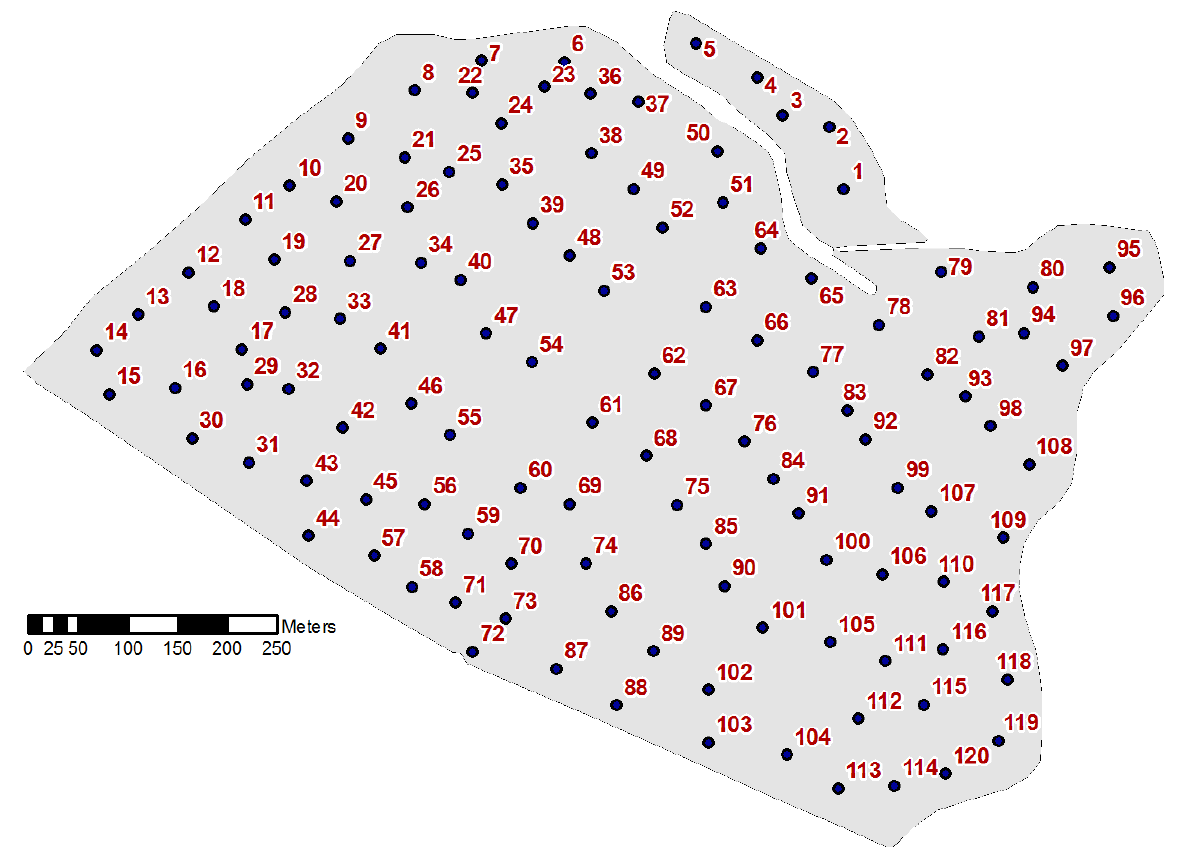
Figure 3: Soil sampling scheme in a 56-ha experimental field in Przeworno (light soil).